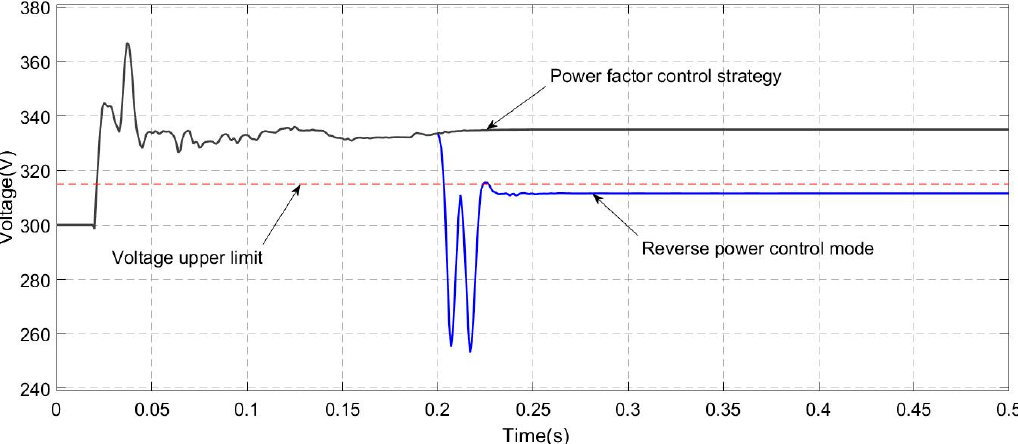
Figure 8. The waveforms of V PCC under power factor control strategy and reverse power control